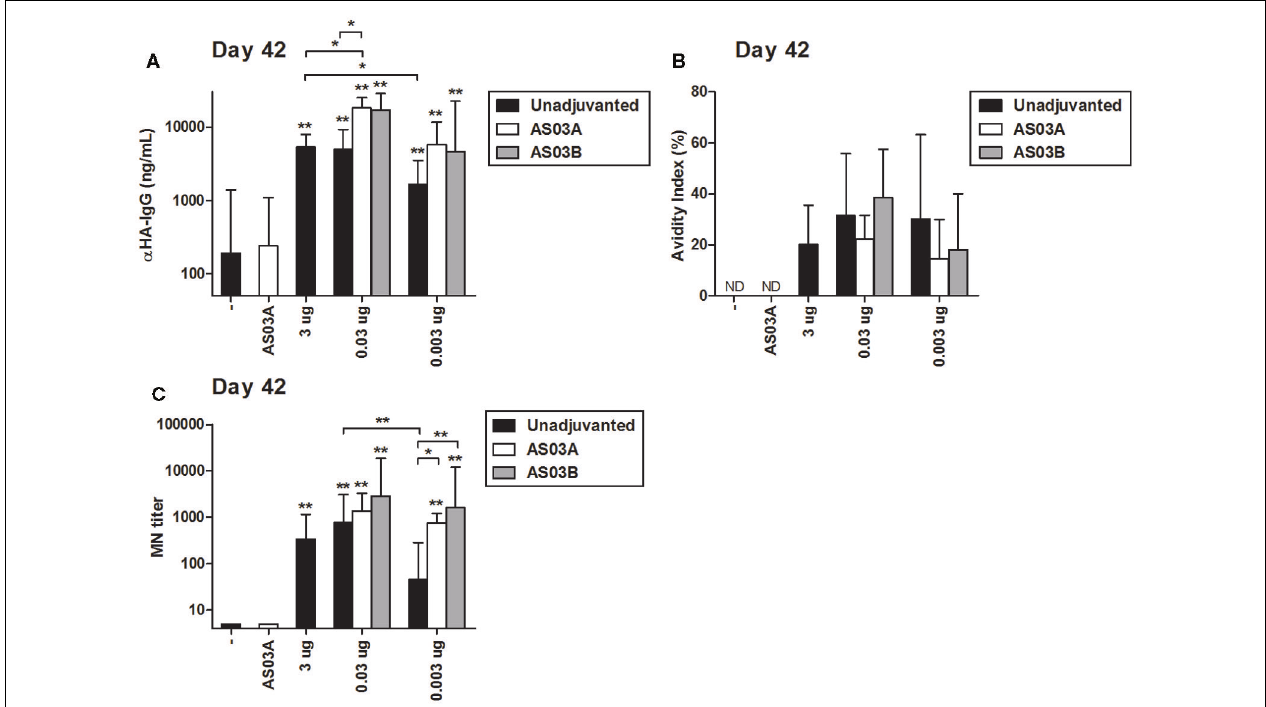
significant increase ( P < 0.05) to negative “ − ” group and ** indicates a significant increase ( P < 0.05) to both negative “ − ” and AS03 A only control groups. Significant differences between groups are denoted by brackets; * P < 0.05; ** P < 0.01; *** P < 0.001. For (A,B) , data represent 4–10 mice per group combined from three independent studies. For (C) , data represent 4–12 mice per group combined from three independent studies. Geometric means and 95% confidence intervals are shown. ND, not